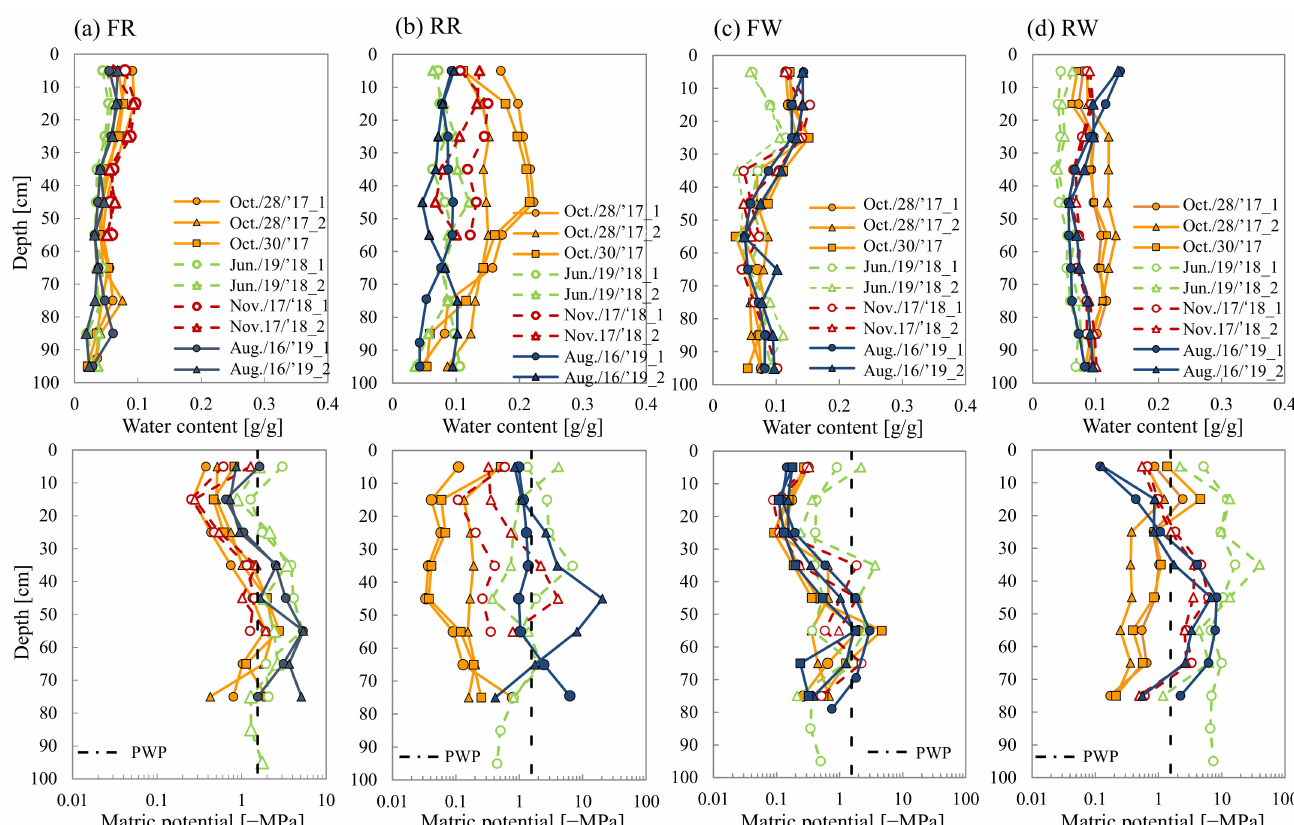
Figure 7. Temporal changes in soil moisture with time. The figures above show the vertical distributions of water content; the others below show that of water potential at ( a ) FR, ( b ) RR, ( c ) FW, and ( d ) RW in 2017–2019. The dashed line represents the permanent wilting point (PWP; − 1.55 MPa). FR is the rapeseed field, FW is the wheat field, RR is the rangeland adjacent to the FR, and RW is the rangeland adjacent to the FW. According to the weather station located 11–13 km southeast of the study sites, no rain and snow was observed in the week preceding 17 November 2018, and rain or snow was observed on 27 October 2017 (=0.5 mm) and 17 June 2018 (=7 mm). We confirmed mottled snow on 28 October 2017 and slight rainfall on